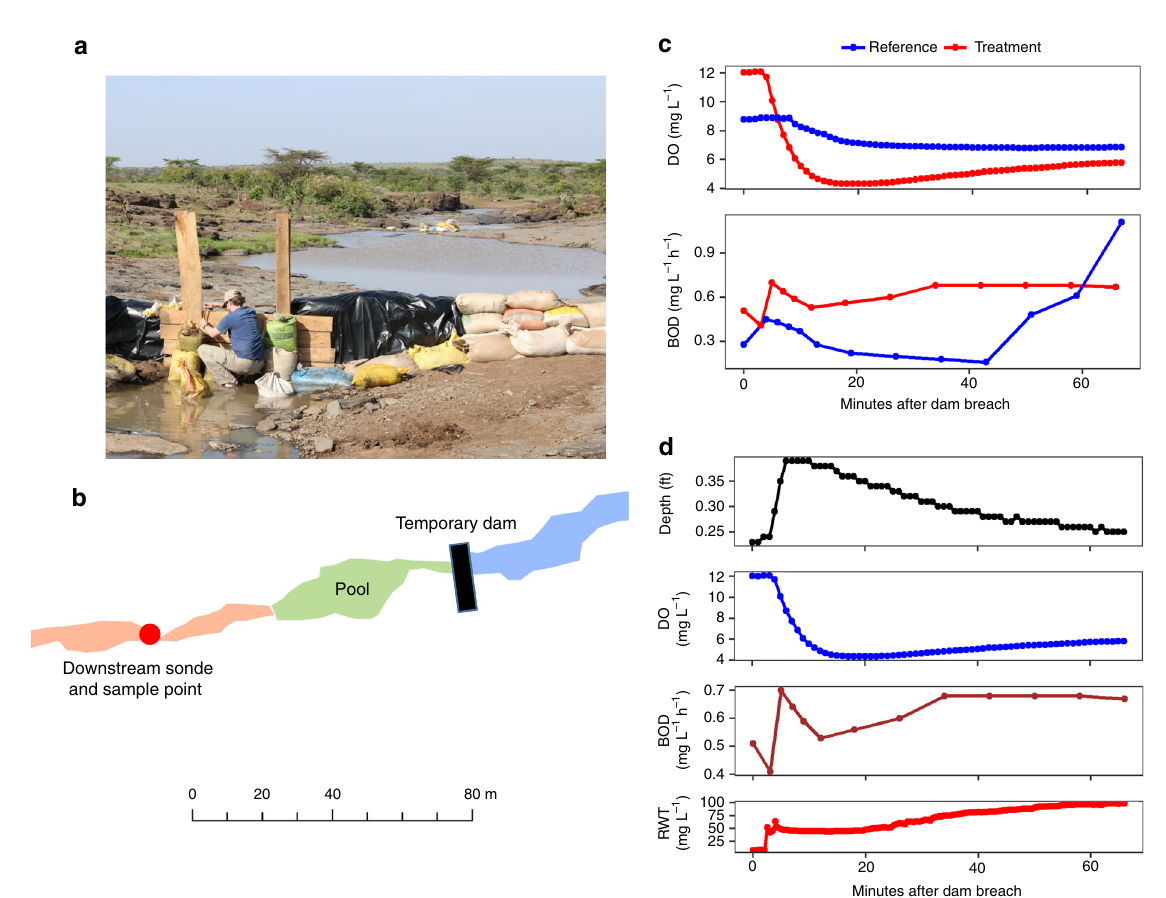
Fig. 3 Experimental fl ush of a reference and treatment hippo pool. a A temporary dam was built upstream of the pool (image credit: Amanda Subalusky). b Map of the pool and sonde/sample location. c Dissolved oxygen (DO) and biochemical oxygen demand (BOD) for the whole-ecosystem manipulation immediately after breaching the dam in the reference and treatment fl ows. d Depth, DO, BOD, and Rhodamine tracer (RWT) immediately after the breach of the dam in the treatment fl